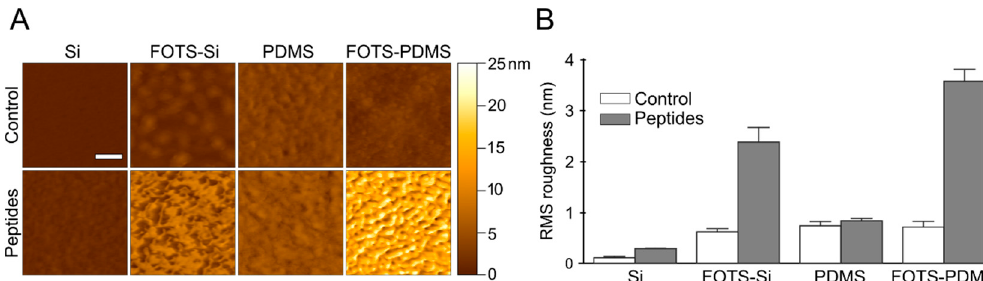
Figure 4. Atomic force microscopy (AFM) of peptide adsorption by microspot patterning. A vehicle control (acetic acid) or collagen peptide solution (250 µ g / mL of GPVI binding peptide (CRP), α 2 β 1 binding peptide (GFOGER), and von Willebrand factor binding peptide (VWF-III) each) was microspot patterned (Figure S2B) on silicon (Si), silicon functionalized with FOTS (FOTS-Si), PDMS, or PDMS functionalized with FOTS (FOTS-PDMS). ( A ) Representative images of each surfaces. Scale bar = 200 nm. ( B ) Average RMS roughness for each surface for n = 3, error bars represent standard deviation.